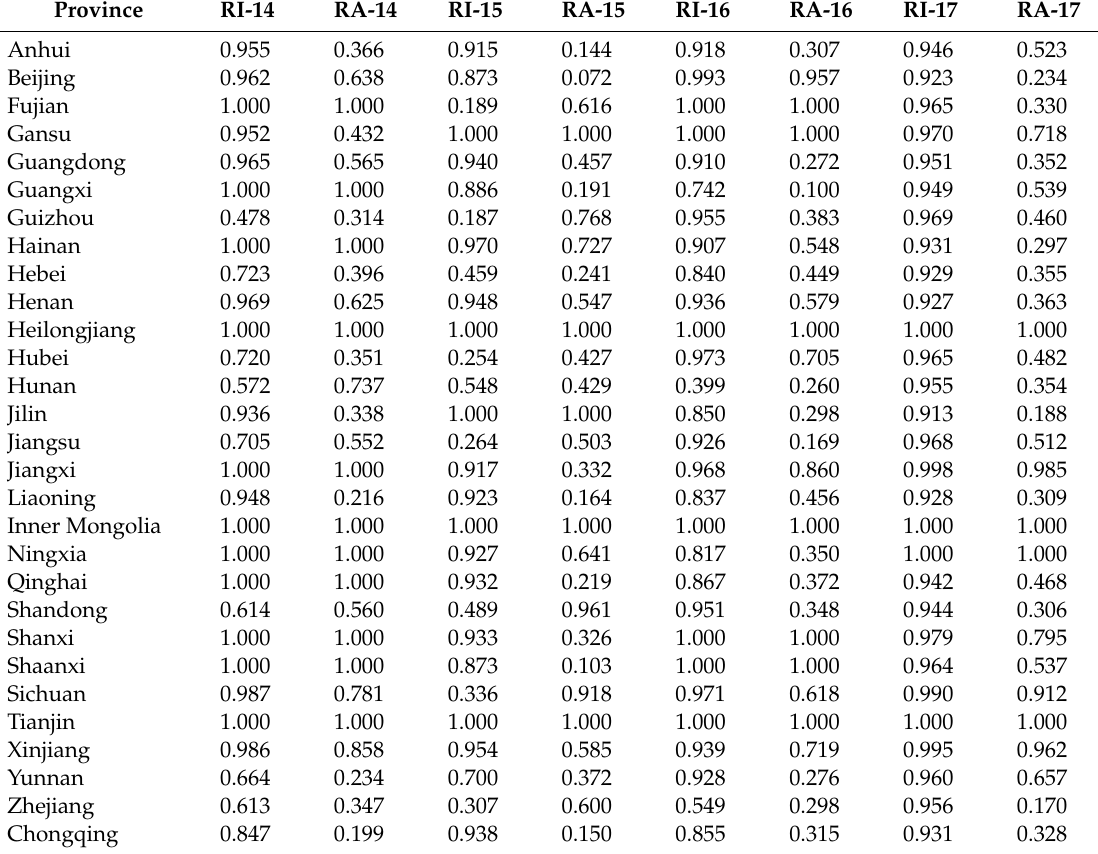
Table 6. Input and output e ffi ciencies in the land rehabilitation